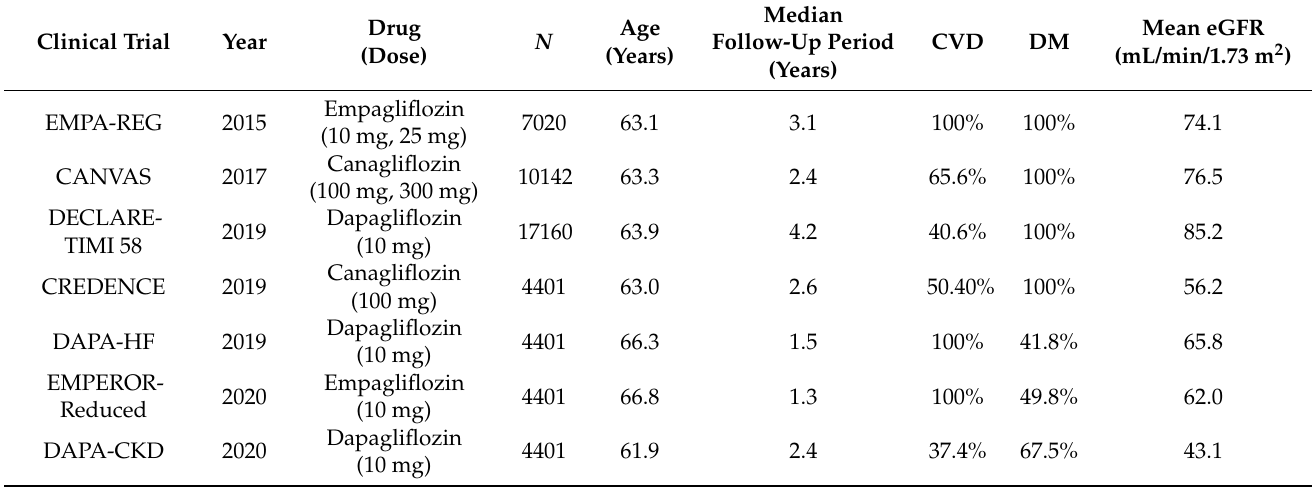
Table 1. Characteristics of patients in SGLT2 inhibitor clinical